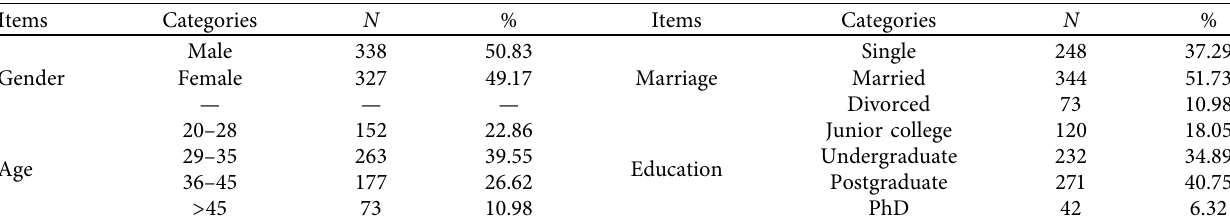
Figure 1: Theoretical model. Table 1: Basic sample